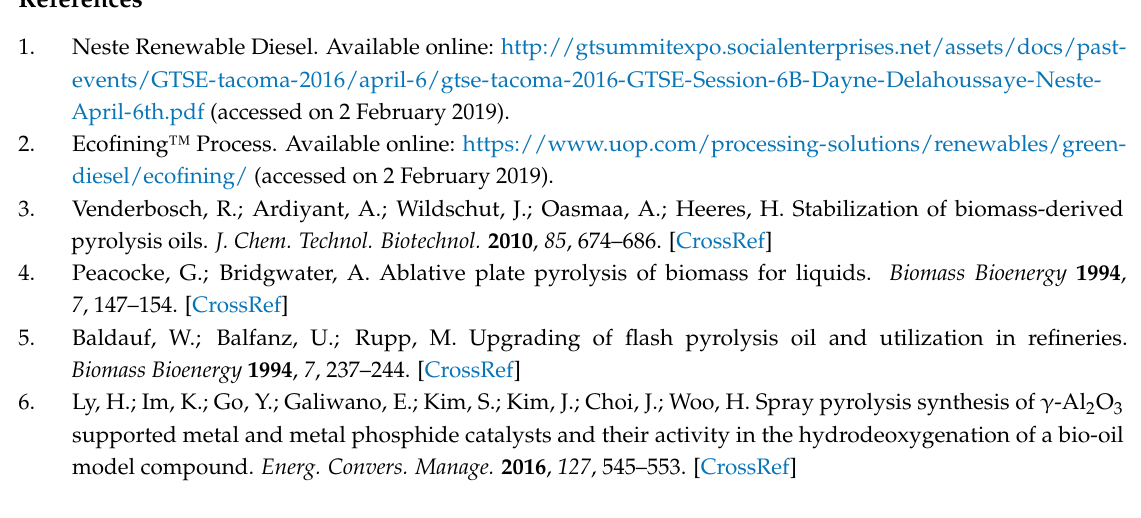
Figure S1. Conversion of guaiacol at 1:2, 1:1 and 2:1 feed-to-catalyst ratio., Figure S2. Selectivity to (a) methoxycyclohexanol, (b) phenol, (c) cyclohexanol, and (d) methanol at 30, 50, and 70 ◦ C for pure